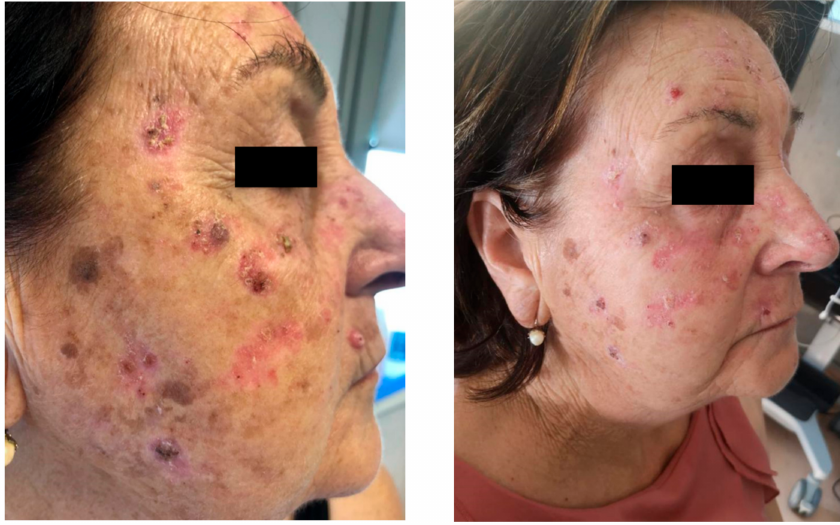
Figure 1. Photo-induced dermatitis in a patient assuming